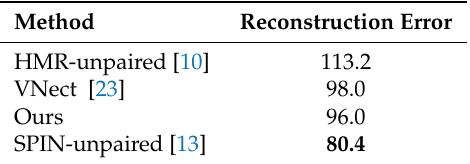
Table 6. Quantitative results of the proposed model and the existing state-of-the-art methods for the MPI-INF-3DHP dataset. The numbers denote reconstruction errors in mm.